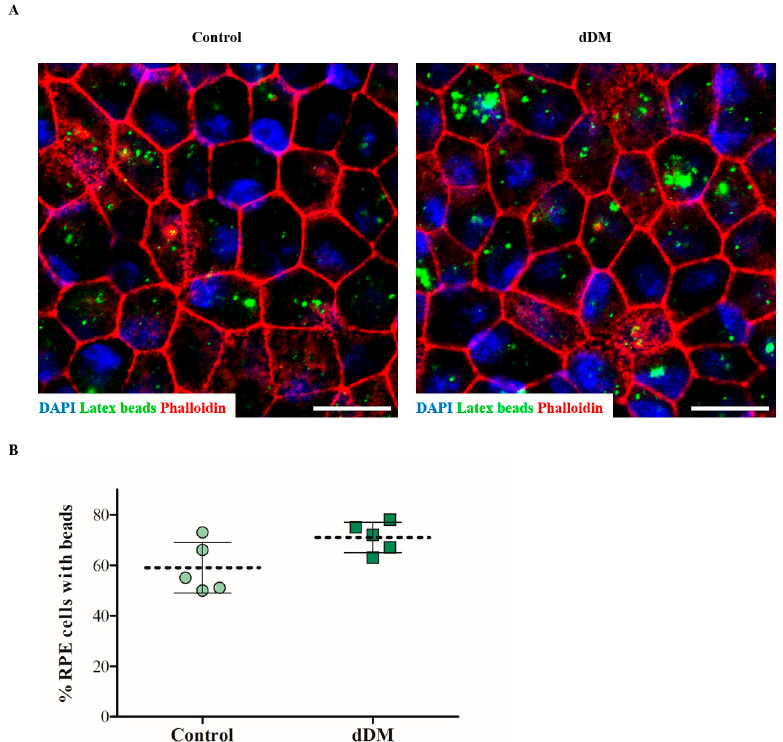
Fig 7. Phagocytic function of pluripotent-derived RPE cells on dDM. ( A ) Latex beads uptake ( green ) in hESC-RPE cells over dDM. Actin filaments were stained with phalloidin ( red ). Scale bar = 50 μ m. ( B ) Percentage of hESC-RPE cells internalizing the fluorescent beads when cultured on the dDM and under control condition, respectively. Latex beads counts were obtained from five individual field if views, with each field containing � 80 cells. Data represent mean ± s.d. � p = 0.062. dDM, denuded Descemet’s membrane.